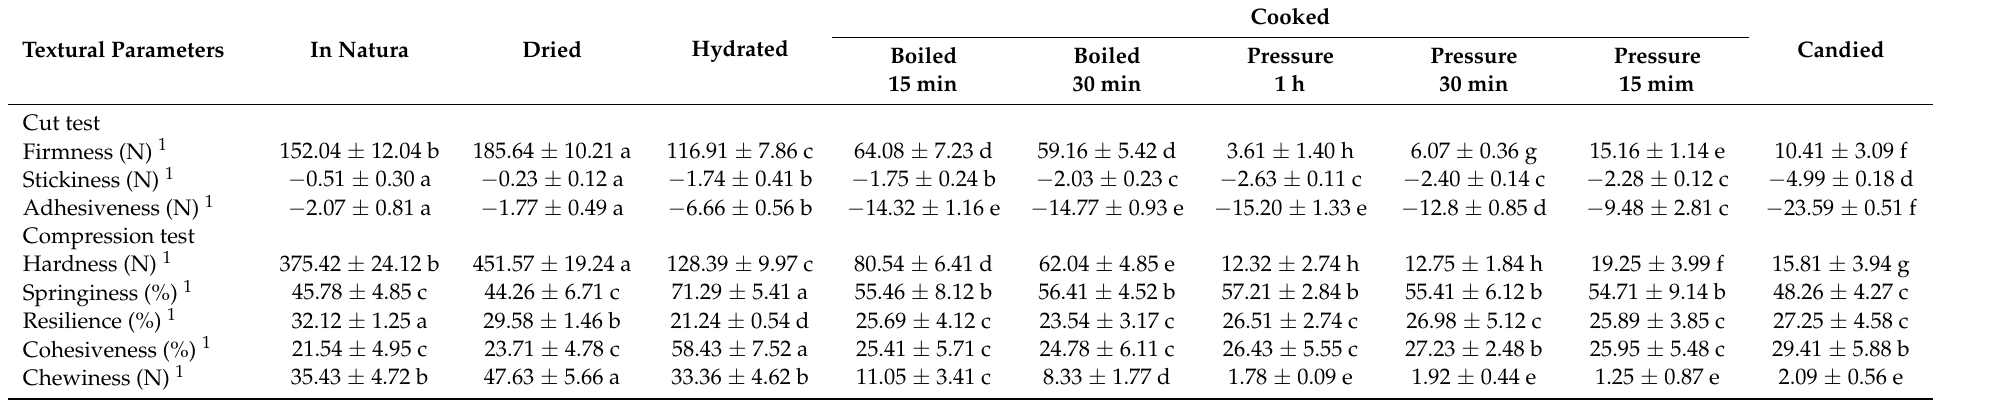
Table 4. Textural parameters along the process and for different cooking